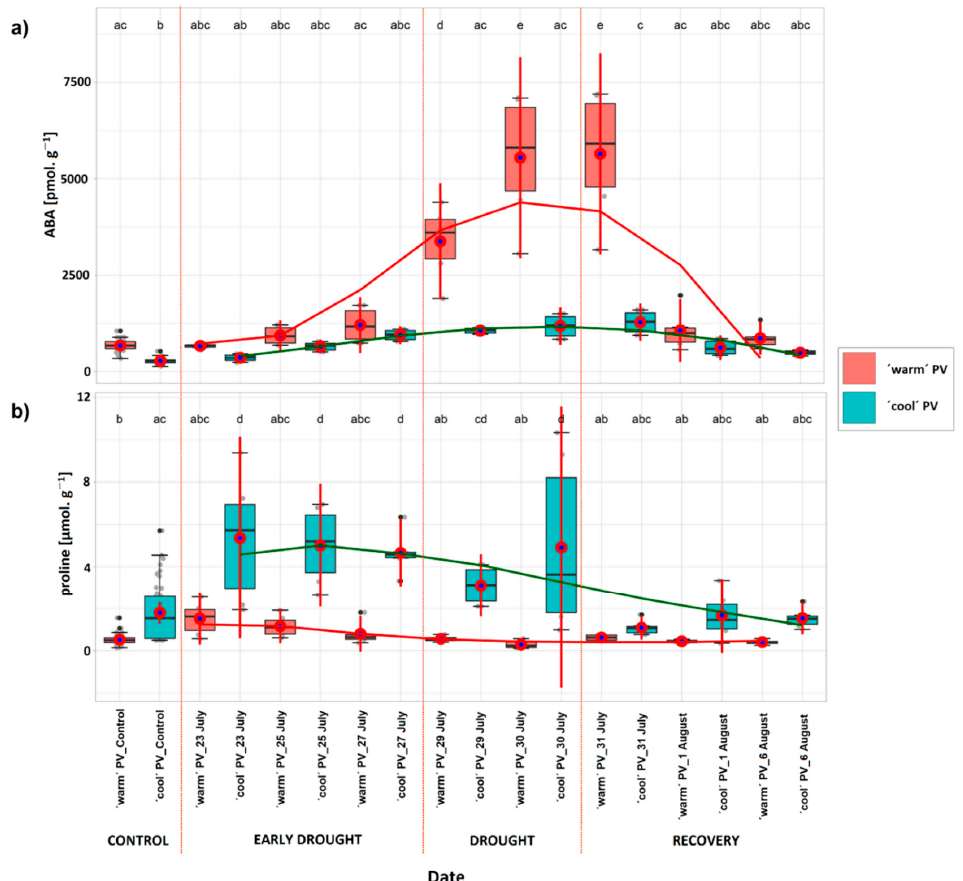
Figure 3. The courses of ( a ) the ABA concentration, and ( b ) proline concentration during dehydration and recovery. Control variants represent the control values from the whole experiment. The graph’s bars with provenance means ± confidence interval ( ± 95%). Di ff erent letters indicate statistically significant di ff erences among groups. Provenances are identified by di ff erent color: ‘warm’ PV (red), ‘cool’ PV (blue).